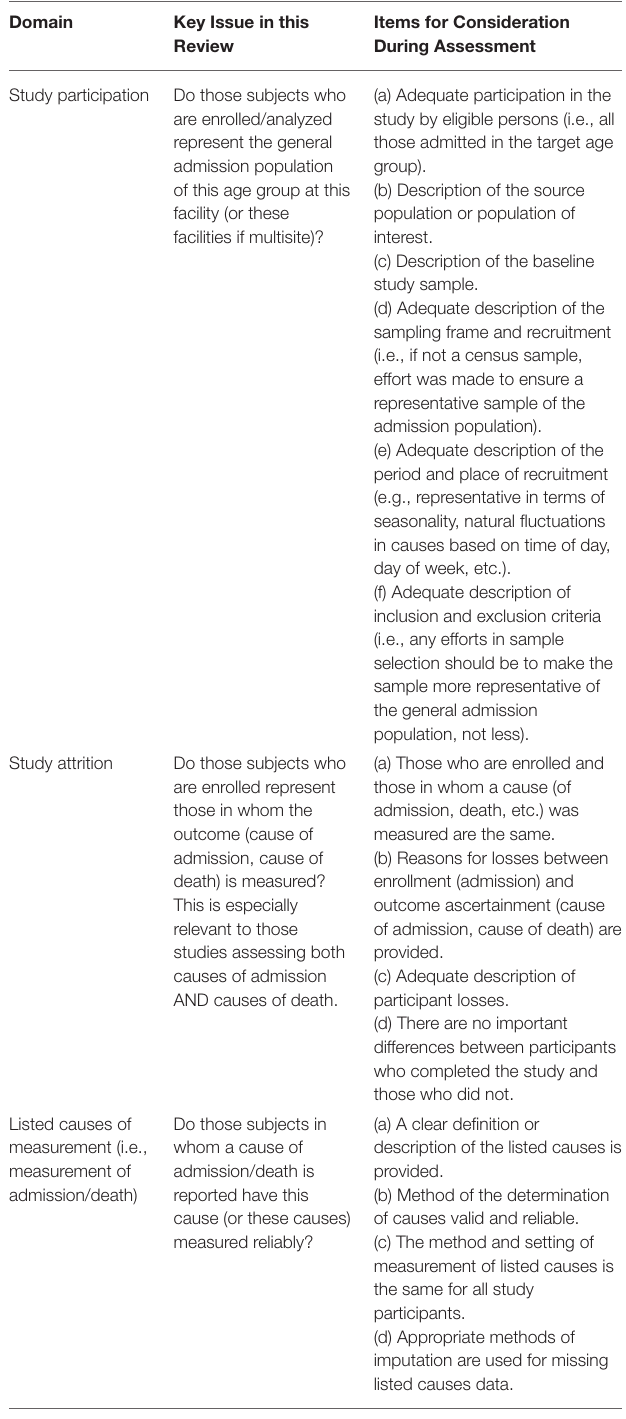
TABLE 2 | Risk of bias domains and questions adapted from the Quality in Prognosis Studies (QUIPS) criteria.